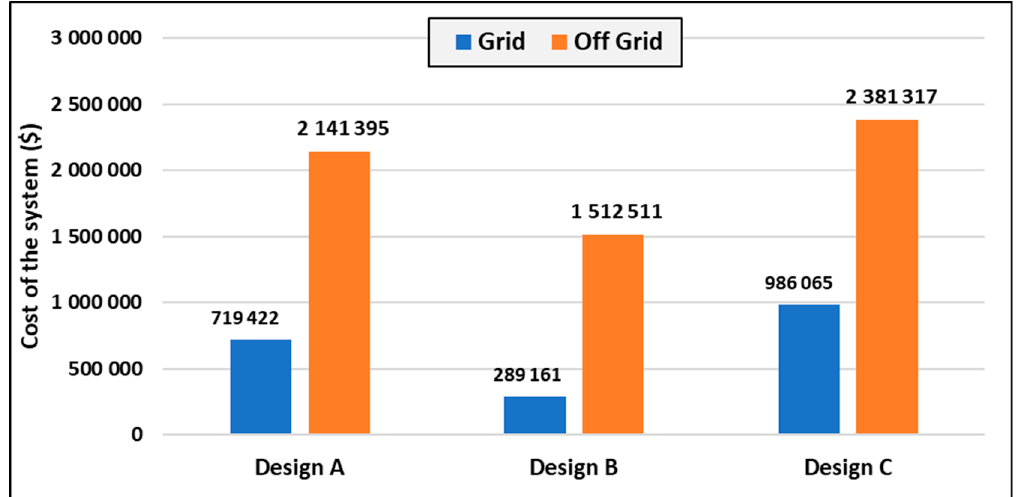
Figure 10. Comparison of grid / o ff -grid connection for optimal designs.